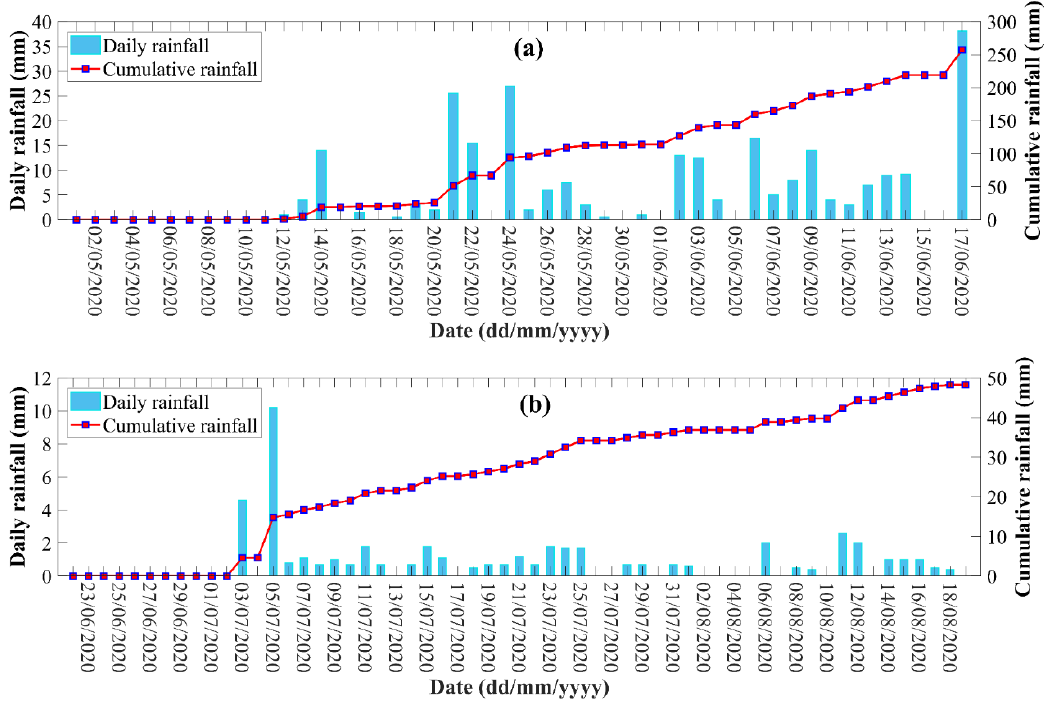
Figure 2. ( a ) Daily rainfall data between 1 May 2020 and 17 June 2020, before the multi-hazard chain, according to the Anianggouer weather station from the Danba Meteorological Bureau. The daily rainfall data were collected from Zhao et al., 2021 [40]. ( b ) Daily rainfall data between 22 June 2020 and 19 August 2020, after the multi-hazard chain, according to the installed rainfall gauge over the ANZ slope. These data were collected from Zhu et al., 2021 [41].